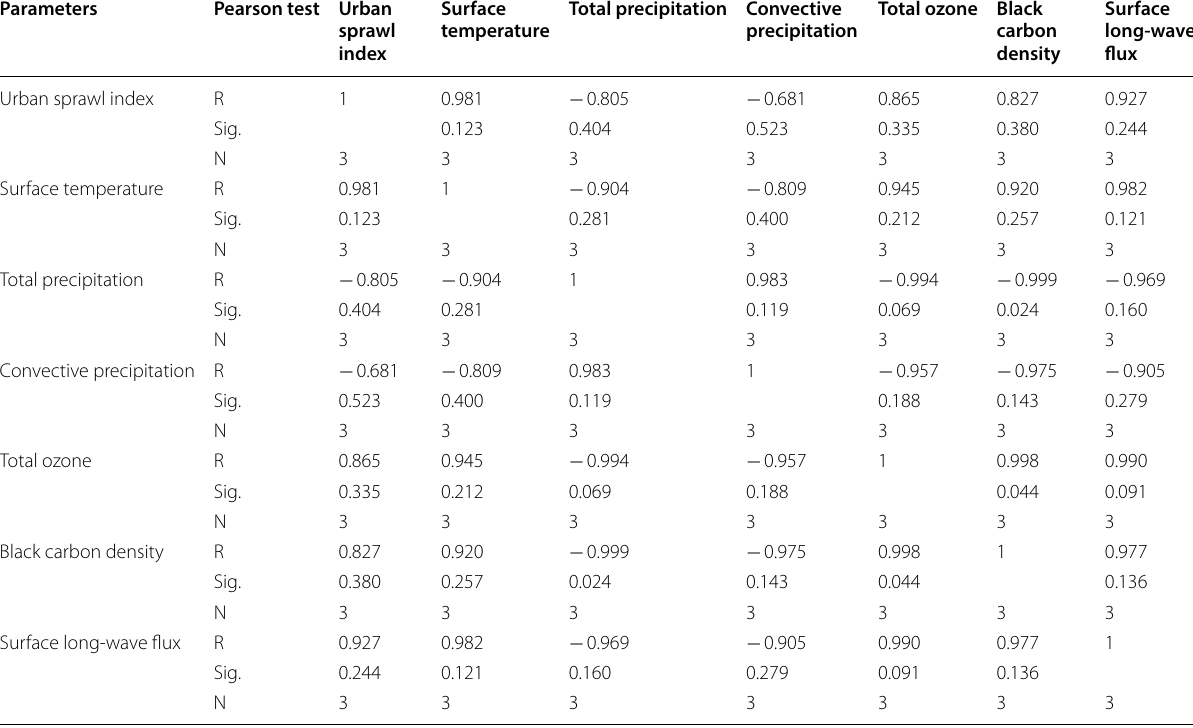
R: correlation ratio, Sig.: significance, N: number of three temporal sequences